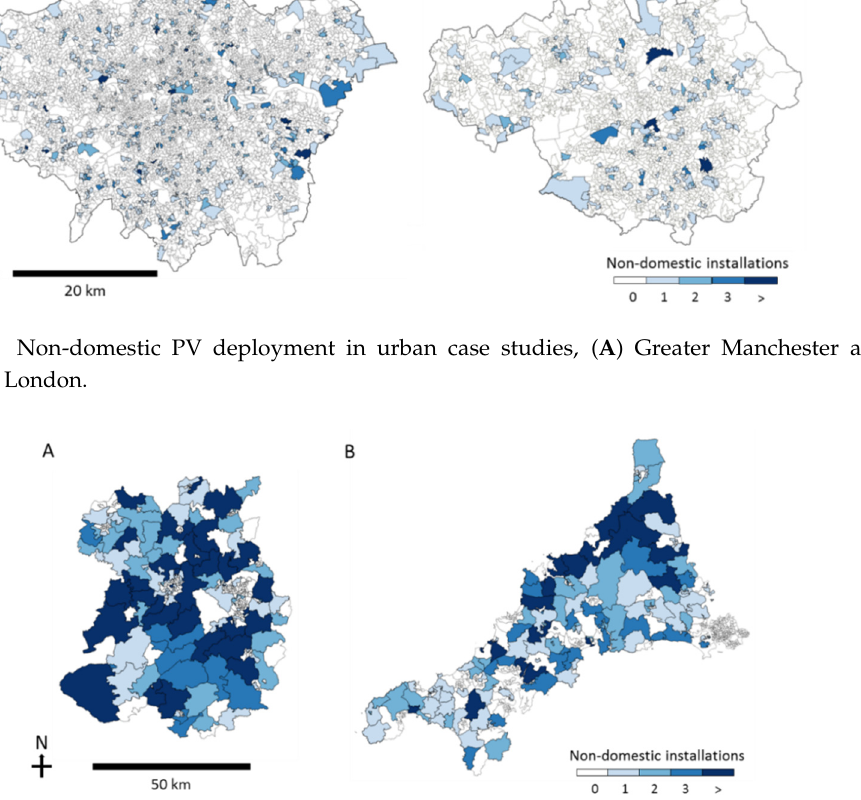
Figure 11. Non ‐ domestic PV deployment in rural case studies, ( A ) Shropshire and ( B ) Cornwall.